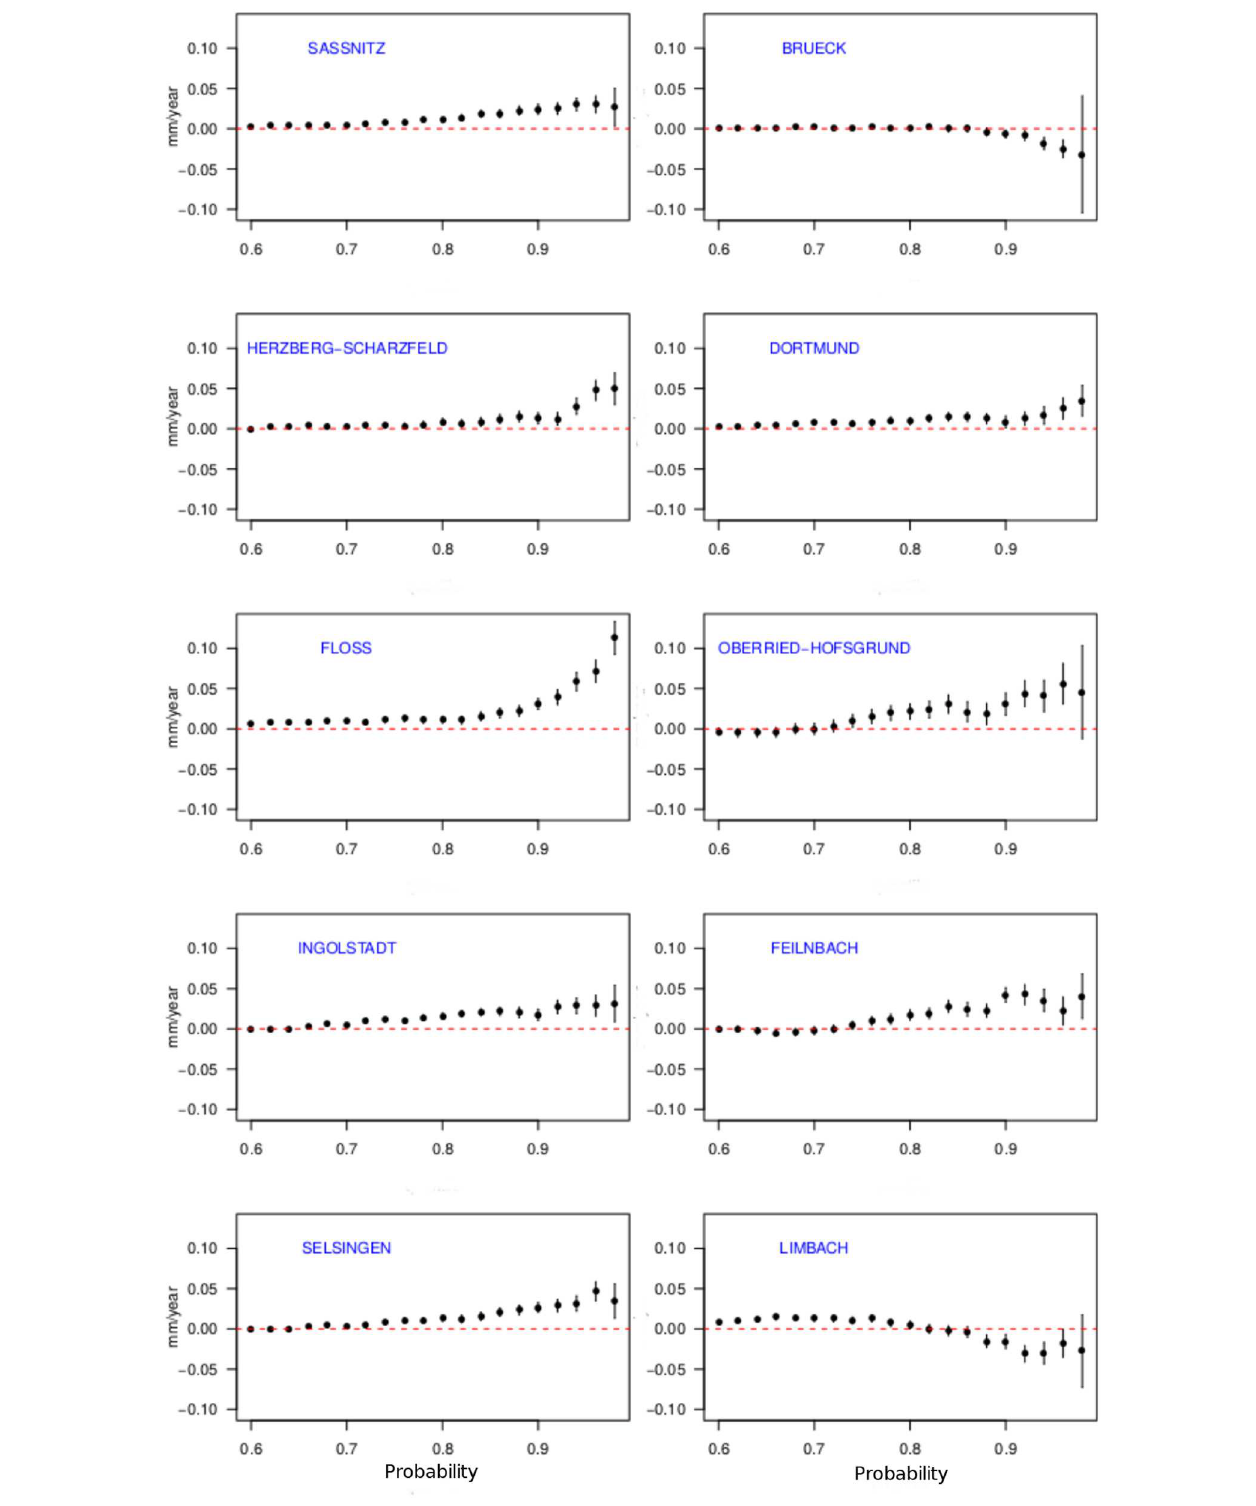
FIGURE 6 | Estimated quantile trends and corresponding uncertainties (vertical error bars) for probabilities τ ≥ 0.6 at 10 different stations in Germany. The uncertainty was calculated using a maximum entropy bootstrap algorithm.